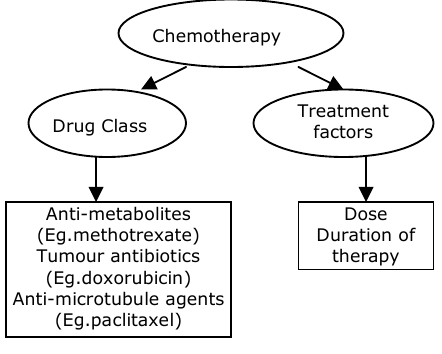
Figure 4 . Cancer therapy (2).